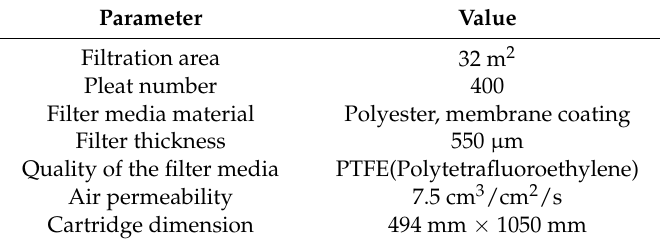
Table 2. The specifications of the filter for the experiment.